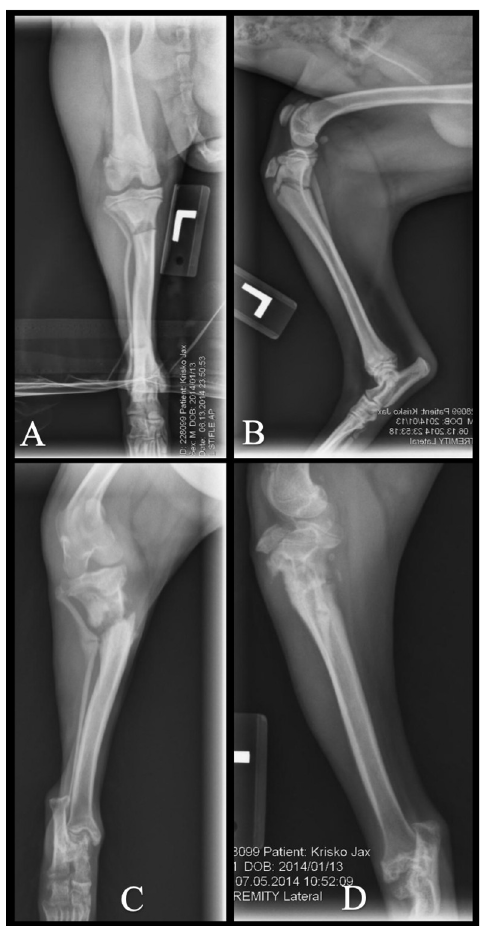
Fig 3. Case 34 managed with a splint bandage alone. A and B: Mediolateral and craniocaudal views at time of injury. C and D: Mediolateral and craniocaudal views 3 weeks post injury demonstrating valgus deviation of the distal tibia. Ultimately development of genu varum, medially luxating patella, tibial tuberosity avulsion fracture, patella alta, tarsal osteopenia, and fibular malunion led to an amputation.